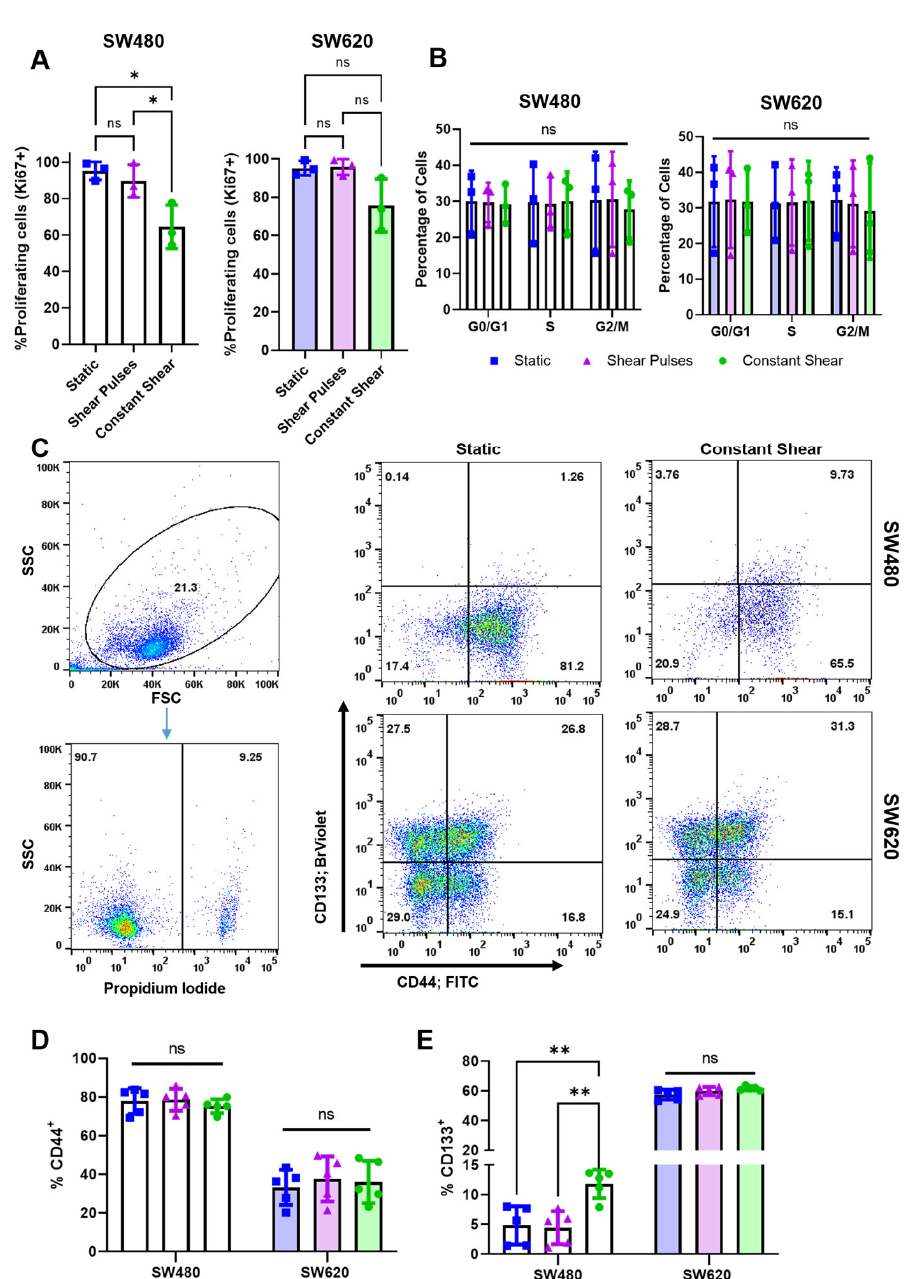
Figure 3. Constant shear stress decreases cell proliferation and increases CD133 expression in SW480 cells. ( A ) Percentage of proliferating cells 24 h post-FSS exposure, determined by the percentage of Ki67+ cells. N = 3, * p < 0.05 (one-way ANOVA with multiple comparisons). Error bars represent mean ± SD. ( B ) Cell-cycle distribution based on total DNA content from DAPI staining analyzed via flow cytometry. A Watson (Pragmatic) model was used in FlowJo to determine the percentage of cells in each stage of the cell cycle. N = 3. ( C ) Expression of CSC markers CD44 and CD133 post-FSS. Cells were gated from debris using forward and side scatter. PI+ cell populations were considered dead and excluded from analysis. Intact, PI- cells were appropriately compensated and gated for expression of CD44 and CD133 using single stained controls. ( D , E ) Quantification of CSC markers CD44 and CD133